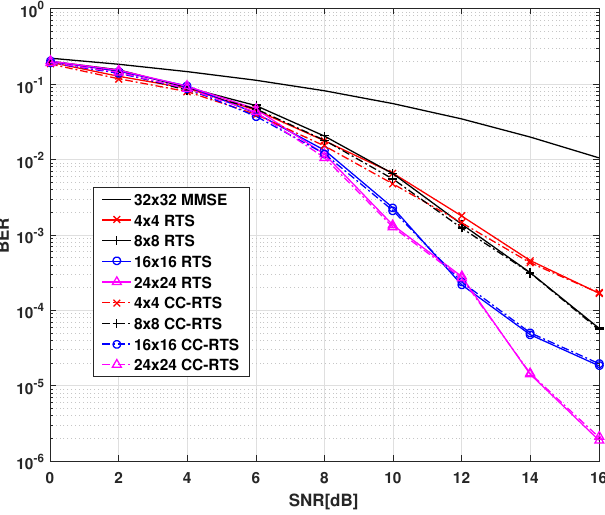
Figure 4. Bit error performance of CC-RTS taking MMSE solution as the initial vector for 4 × 4, 8 × 8, 16 × 16, 24 × 24 MIMO system with Channel with Doppler Frequency Shift, QPSK modulation, d th =